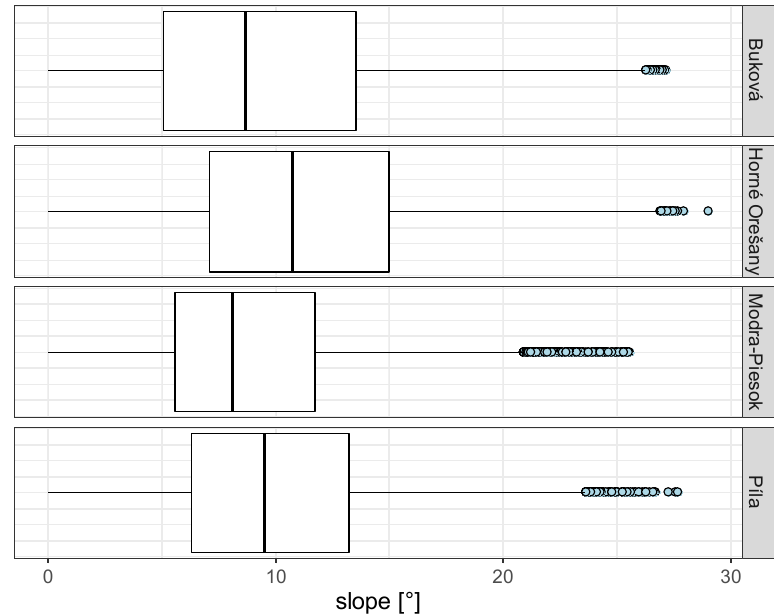
Figure 6. Distribution of slopes, evaluated by boxplots.